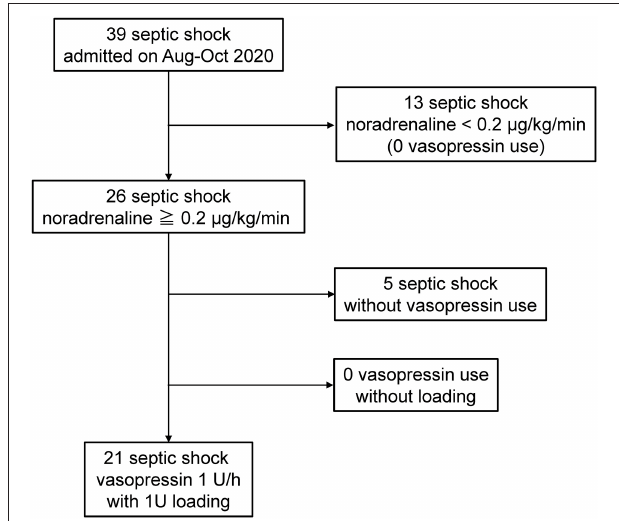
FIGURE 1 | Study outline. Twenty-one consecutive patients with septic shock administered vasopressin with loading under noradrenaline > 0.2 µ g/kg/min. Bolus loading with 1U following by continuous administration with 1 U/h was performed for all patients.